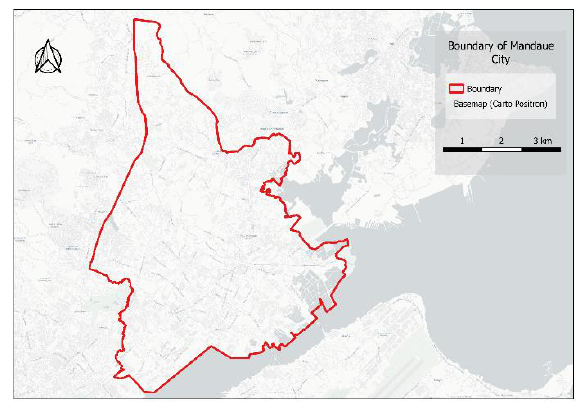
Figure 1 . Mandaue City, in Cebu Province